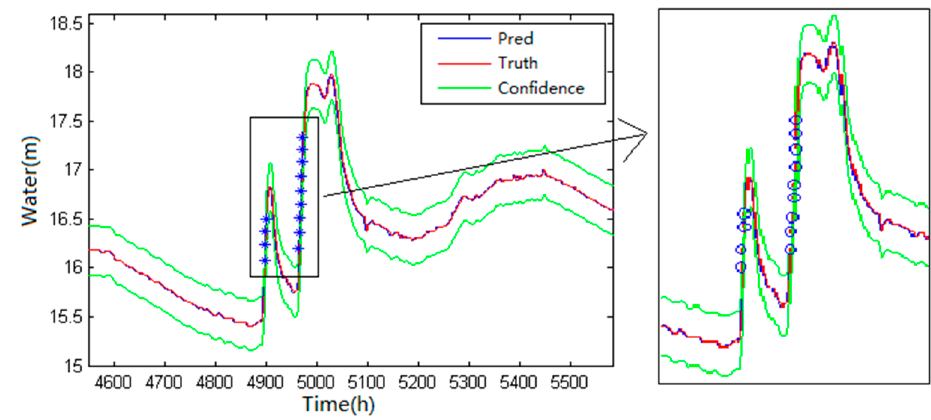
Figure 13. Predictive control effect of the flood season in the Guxiandu station.